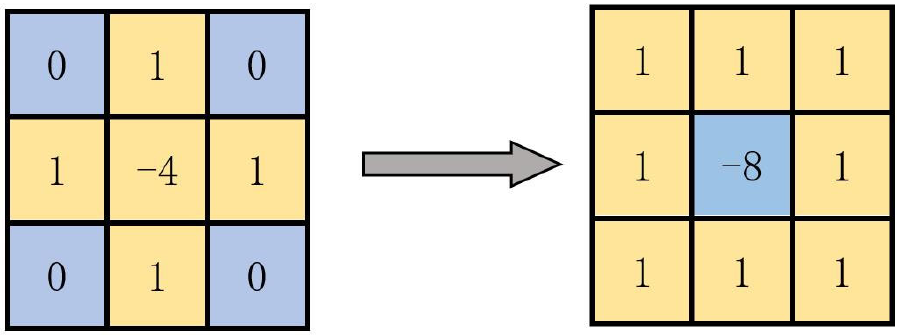
Figure 5. Improvement of the filter kernel.